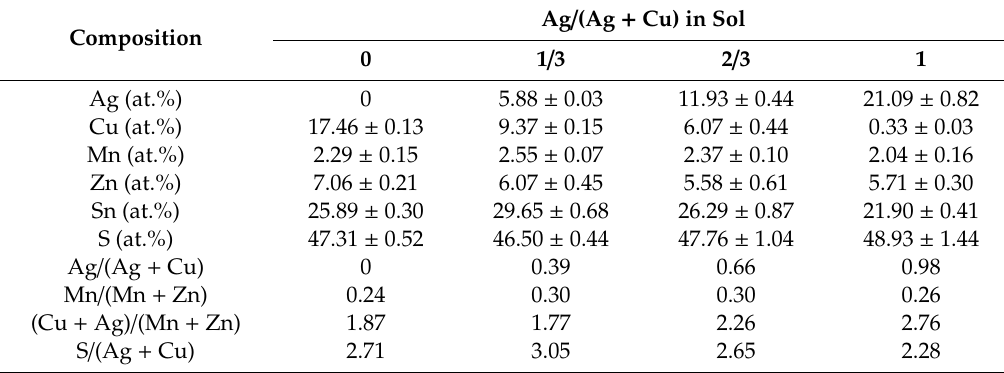
Table 1. The compositions of Ag and Mn co-doped Cu 2 ZnSnS 4 thin films.